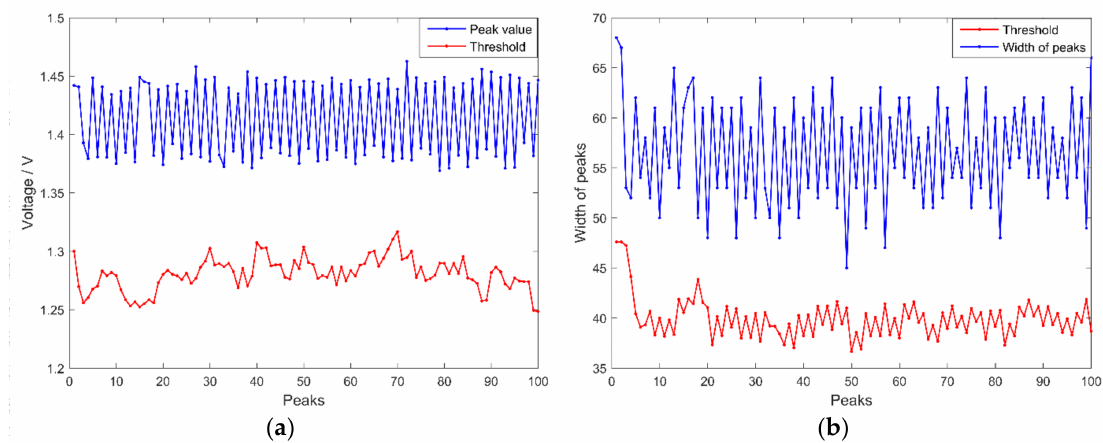
Figure 9. Self-adaption thresholds changed with the variation of 100 peaks: ( a ) ε (m) changed with variation of height; and ( b ) ϕ (m) changed with variation of width.